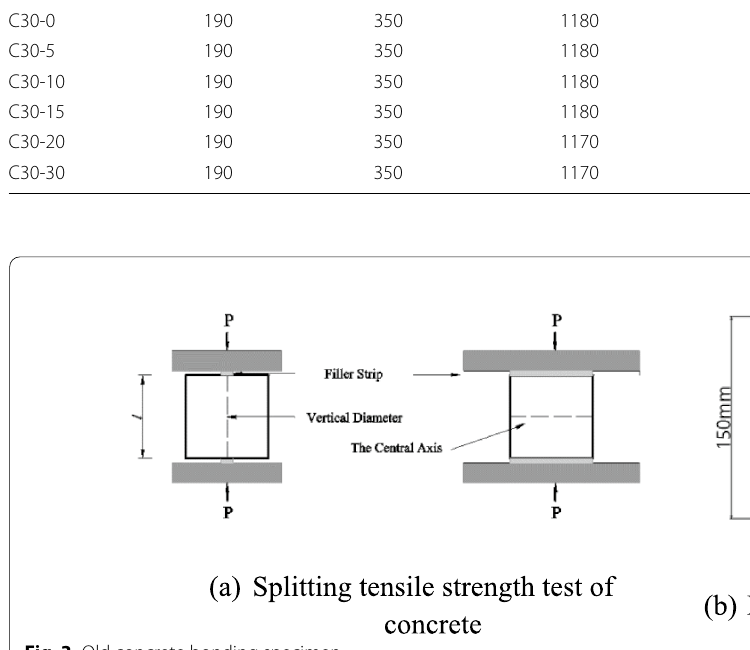
Fig. 3 Old concrete bonding specimen.